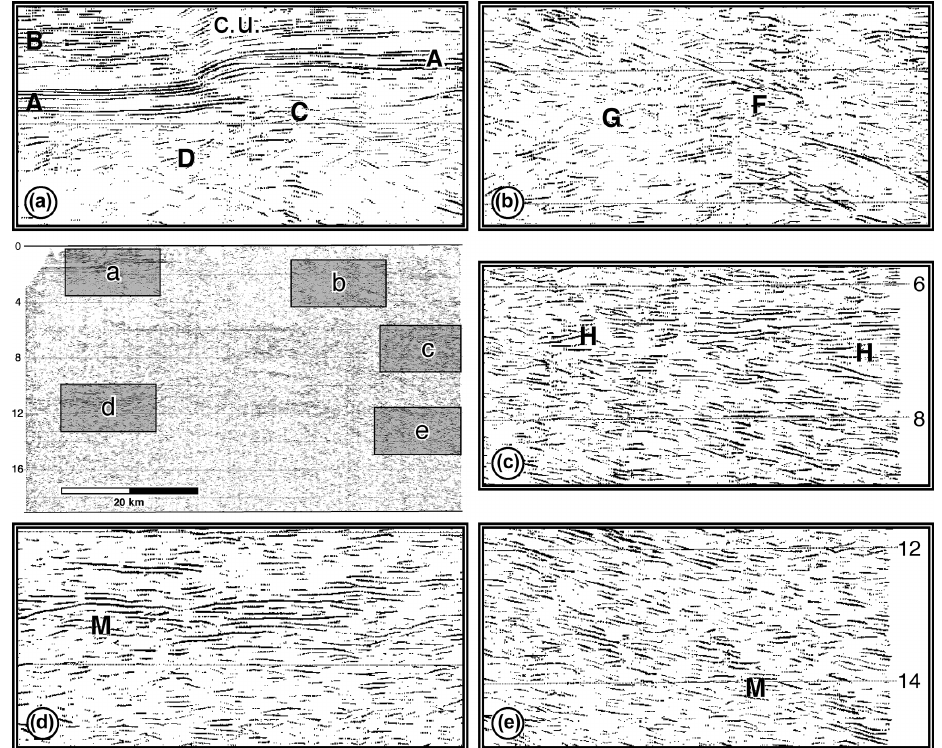
Figure 6. Magnification windows from selected regions of ESCIN-2. (a) Campillo thrust (C) and Campillo uplift (c.u.) in the Duero basin. (b) North-dipping band of reflectors interpreted as crustal scale thrusts (F and G). (c) Wedge of subhorizontal reflectors indented in the crust (H). (d) Horizontal reflection Moho (M) at the base of the crust (11s) beneath the Duero basin. (e) North-dipping reflection Moho at the base of the crust reaching a depth of 15s below the Cantabrian